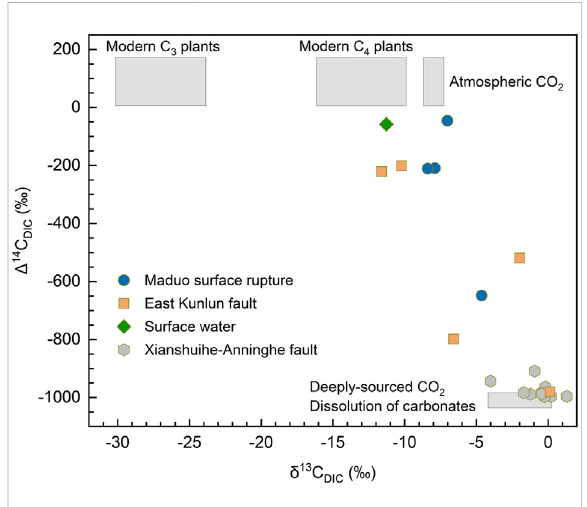
FIGURE 2 Plot of Δ 14 C DIC versus δ 13 C DIC for spring and surface water samples in the study area. Data of the Xianshuihe-Anninghe fault zone are from Xu et al.